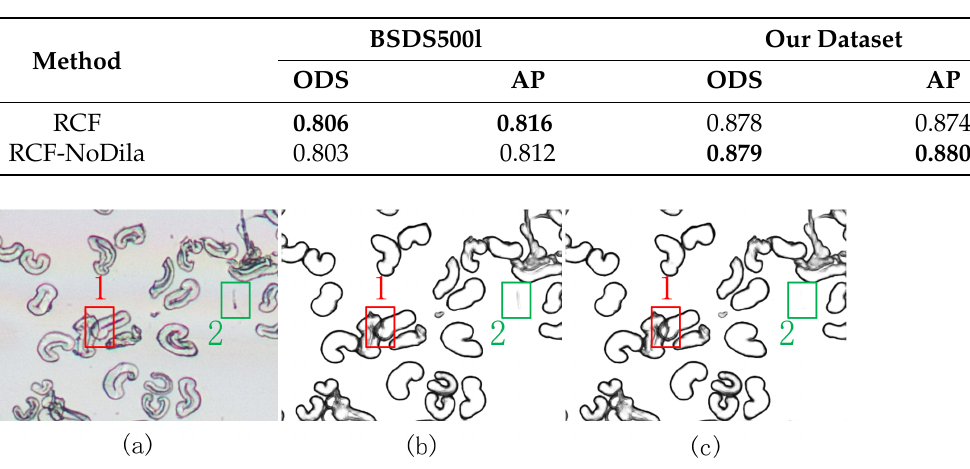
Table 2. Comparison of edge detection results of dilated convolution on different datasets.